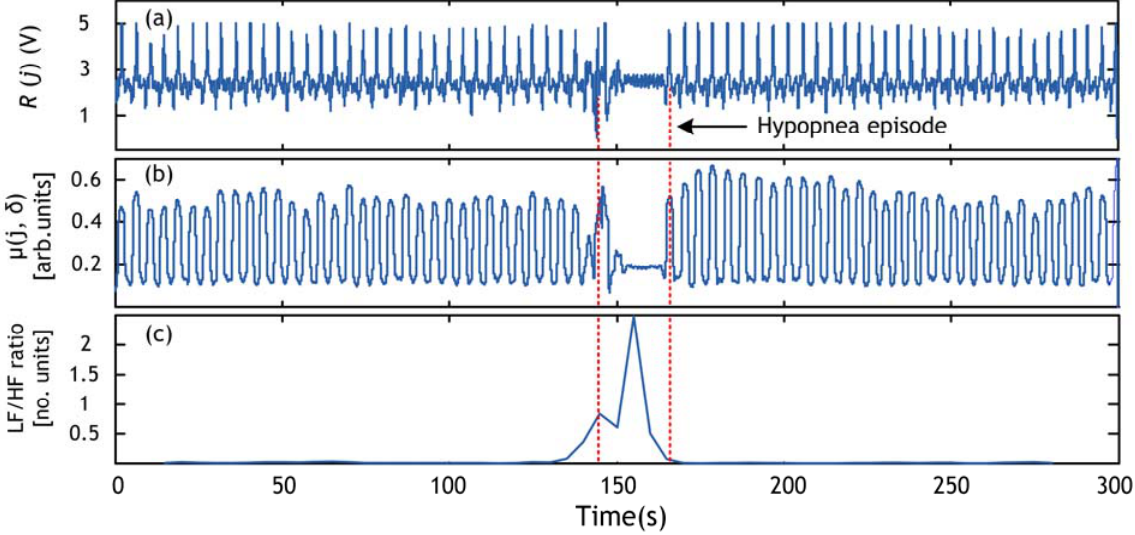
Figure 10. Hypopnea detection using respiratory cycle variability (RCV) for record 1. (a) PVDF sensor output. (b) Respiration signal derived from (a) using local energy calculation. (c) LF/HF ratio. Hypopnea episode is shown by broken